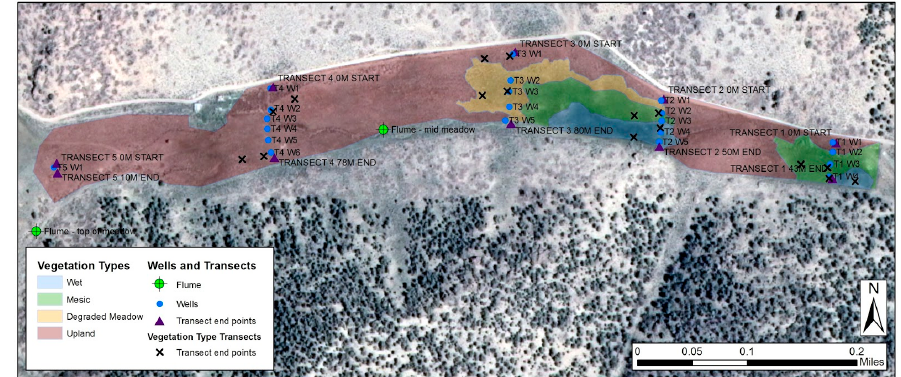
Figure A1. Porter Canyon meadow vegetation types and monitoring locations. Meadow phenocam focuses on the T2 transect of monitoring wells (see Figure 3 for alternate angle).